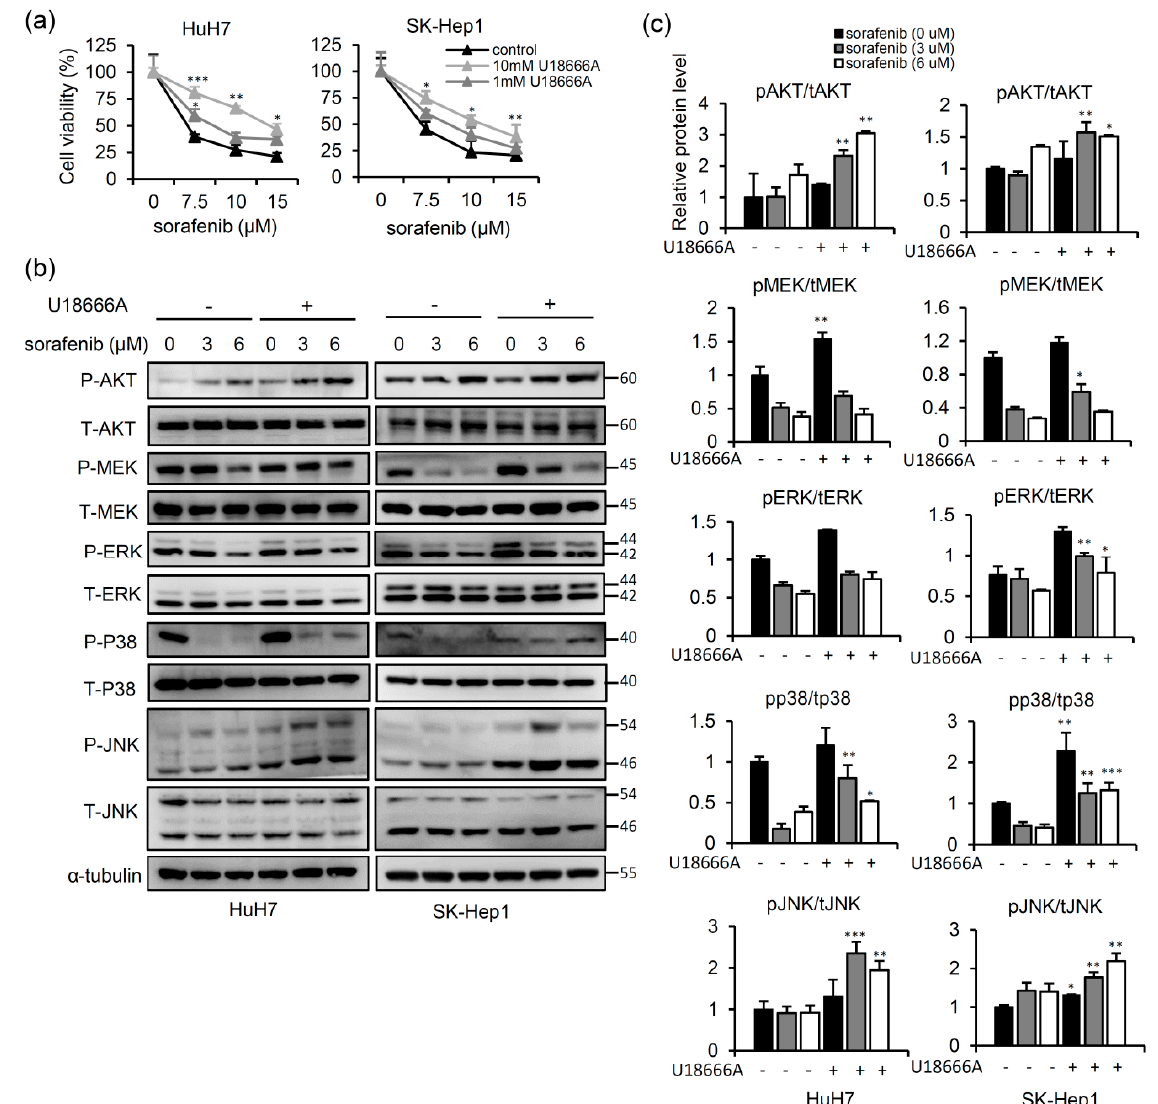
Figure 2. U18666A treatment induces free cholesterol accumulation, which weakened sorafenib-induced cytotoxicity through enhancing mitogen-activated protein kinase (MAPK)/AKT signaling in liver cancer cells. ( a ) HuH7 and SK-Hep1 cells were treated with sorafenib (0, 7.5, 10, and 15 µ M) and U18666A (0, 1, and 10 mM) for 48 h and then harvested for an MTT assay. ( b ) HuH7 and SK-Hep1 cells were treated with sorafenib (0, 3, and 6 µ M) and U18666A (0 and 10 mM) for 48 h, and protein expression levels of AKT, MAPK kinase (MEK), extracellular signal-regulated kinase (ERK), p38, and c-Jun N-terminal kinase (JNK) were detected by western blotting. α -tubulin was used as an internal control. These experiments were repeated three times with similar results. ( c ) Western blot images were quantified with the Image J software. * p < 0.05, ** p < 0.01, *** p < 0.001 compared to U18666A untreated